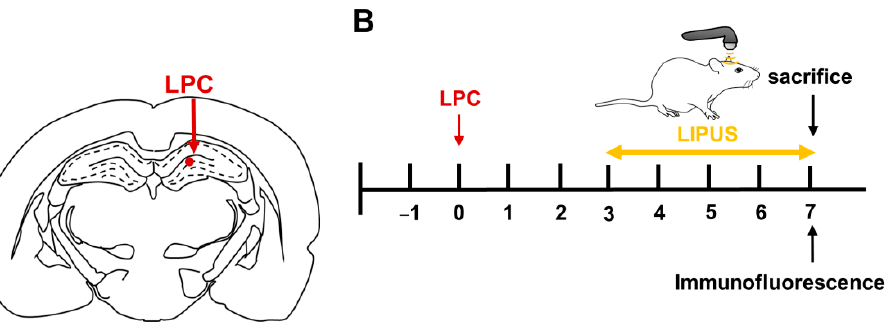
Figure 6. Experimental protocols. ( A ) Schematic diagram of LPC injections into the hippocampus. ( B ) The time course of the study. Rats were treated daily with LIPUS for 5 days and then sacrificed at seven days following LPC administration.